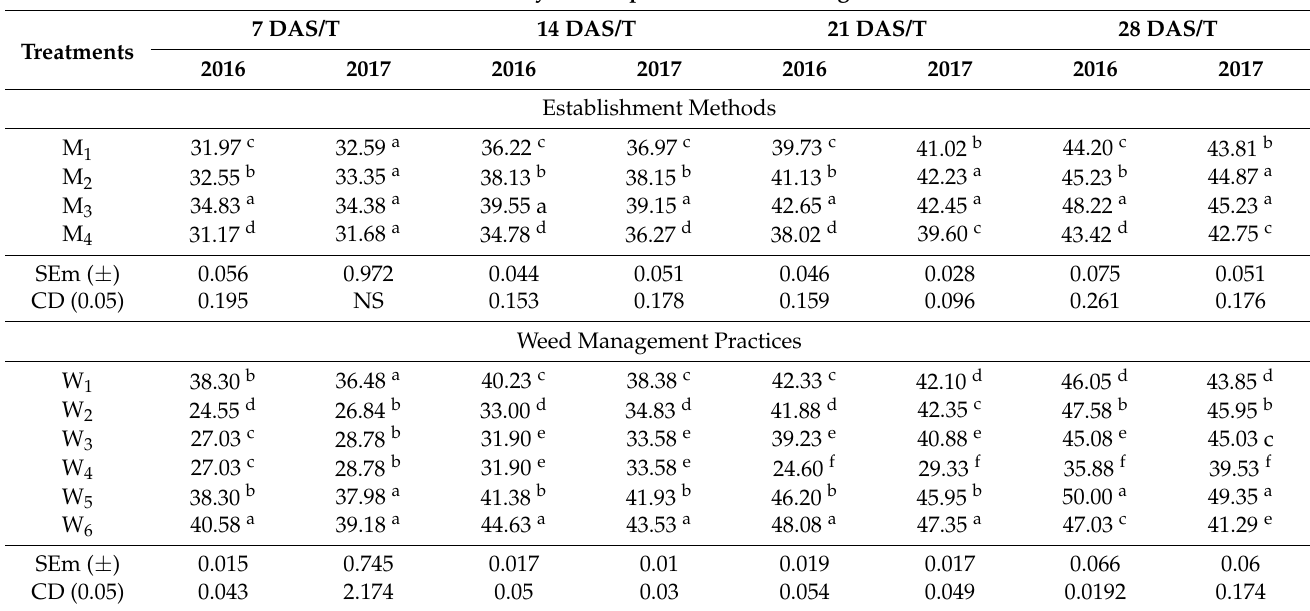
Table 7. Total Actinomycetes population ( × 10 3 CFU g − 1 soil) in rice soil as influenced by crop establishment methods and weed management